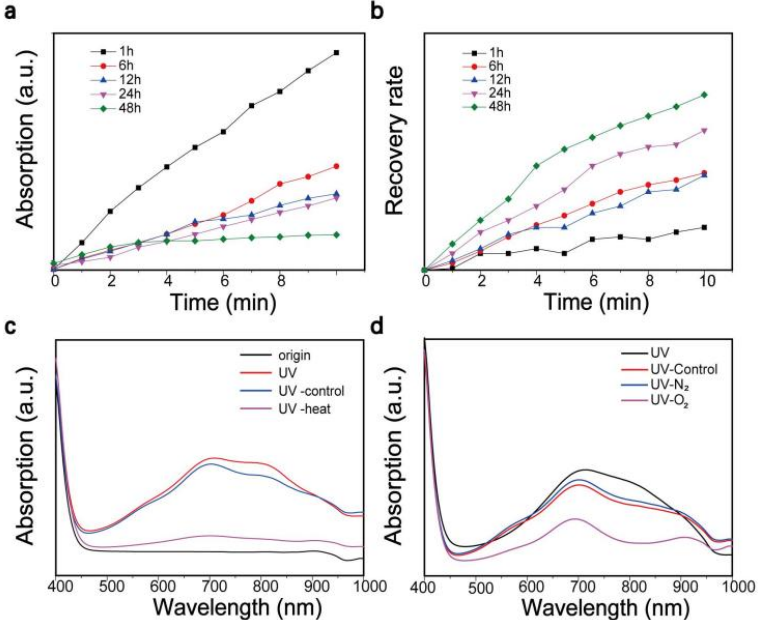
Figure 5. ( a ) The absorption peaks of MoO 3 ‐ x nanostructures under UV 10 min of UV irradiation using a Xenon lamp, samples were obtained at different reaction times. ( b ) The self ‐ recovery rate of MoO 3 ‐ x nanostructures obtained at different reaction times after 10 min of UV irradiation using a Xenon lamp. The recovery rate is defined as the ratio of the amount of absorption intensity recovered to the absorption intensity before recovery. ( c ) The effect of heating on photochromism of MoO 3 ‐ x nanostructures. Origin sample was irradiated for 10 min to create a UV sample, then the UV sample was divided to two parts, treated with and without 20 min heating, marked as UV ‐ heating and UV ‐ control. ( d ) The effect of oxygen on photochromism of MoO 3 ‐ x nanostructures—the UV sample was obtained via irradiation for 10 min and samples treated with O 2 , N 2 , and air were marked as UV ‐ O 2 , UV ‐ N 2 , and UV ‐ control, respectively.